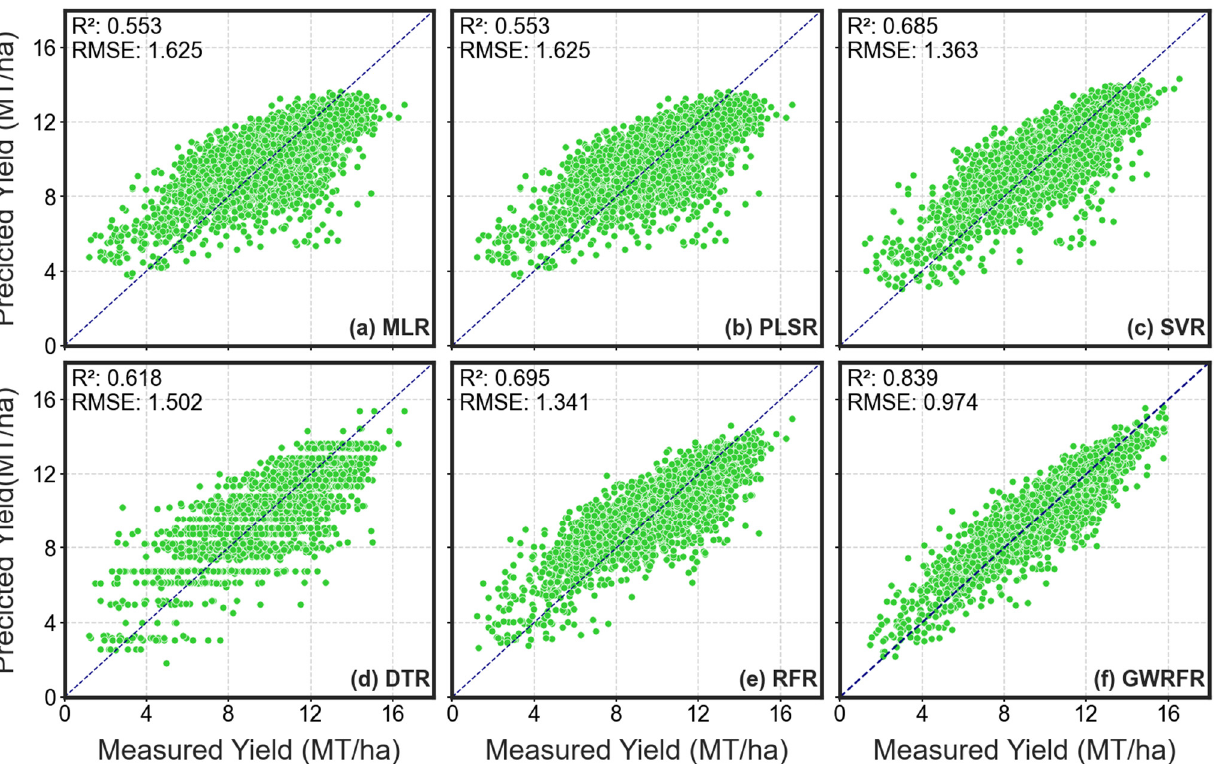
Figure 7. The scatterplots of the actual yield and the predicted yield derived from ( a ) MLR, ( b ) PLSR, ( c ) SVR, ( d ) DTR, ( e ) RFR, and ( f ) GWRFR using only GPP data.